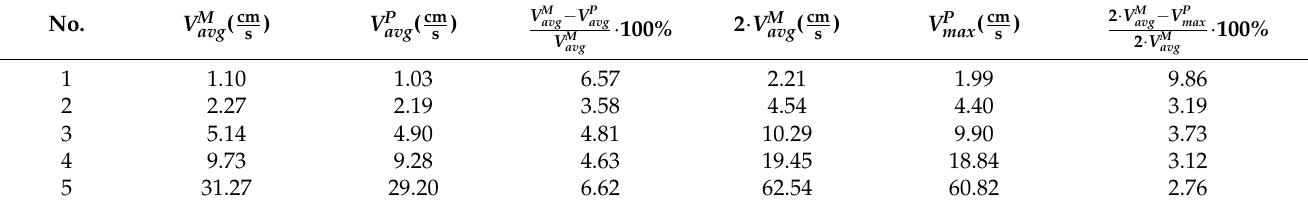
Table 2. Summary of calculated manometer indications of V M avg with the measured average velocity V P avg and measured maximal velocity V P max